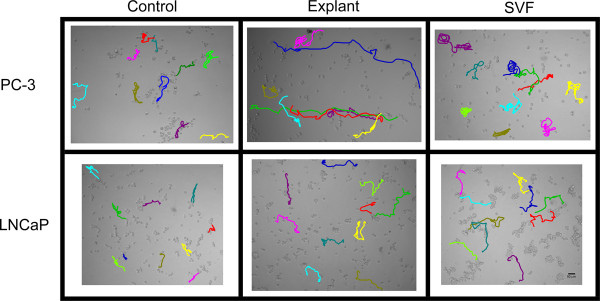
Representative example of cell tracking and cancer cell trajectories after stimulation with periprostatic adipose tissue-derived CM. Sequential displacements of cells were captured by manual cell tracking and are represented as color lines. SVF, stromal-vascular fraction.